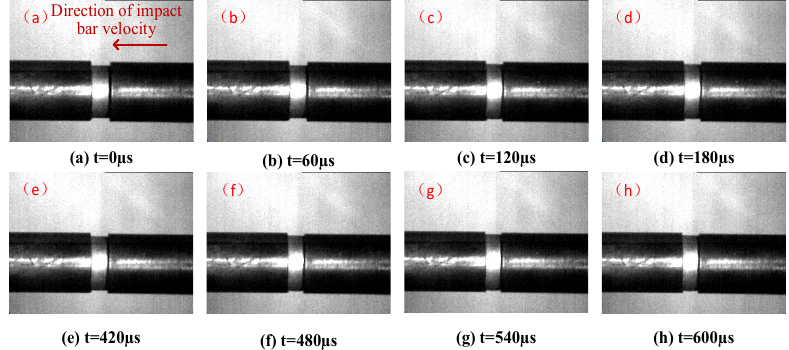
Figure 10. Experiment No.12 dynamic compression process.